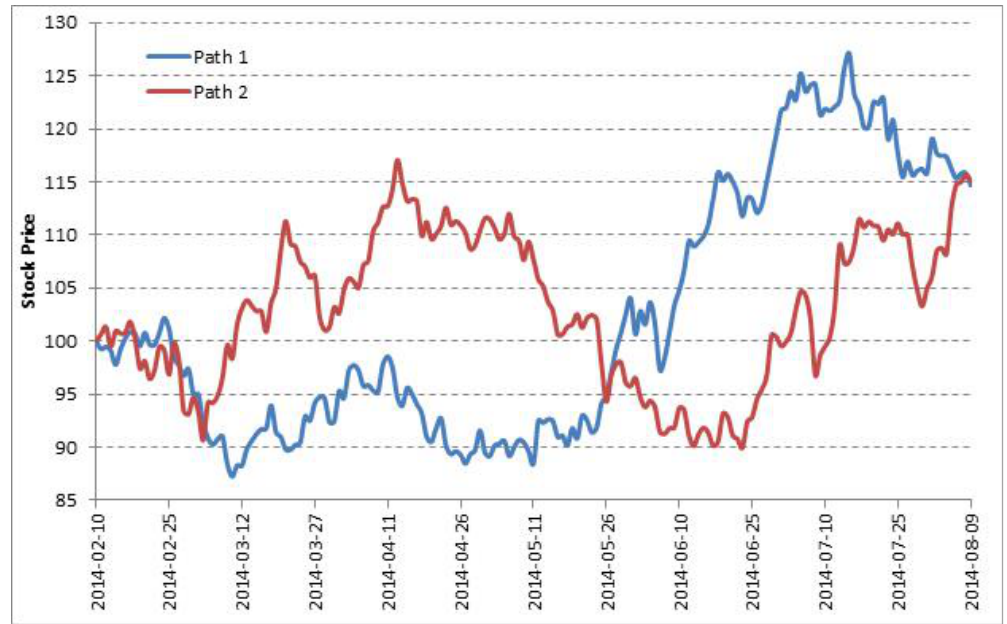
Figure 3. Two simulated price paths of some stock with a 30% volatility over a six month